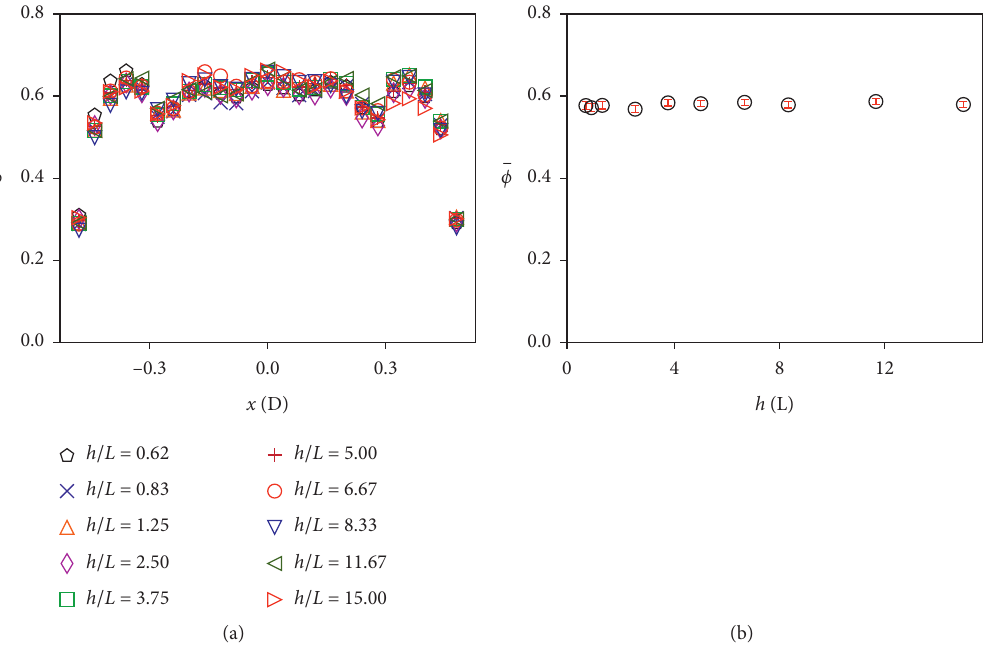
Figure 6: Results of volume fraction for different pebble bed heights h . (a) Horizontal profiles of the volume fraction versus the position x normalized by the orifice size D for various particle bed heights. (b) Average values of volume fraction ϕ versus the particle bed height h normalized by the hopper width L .